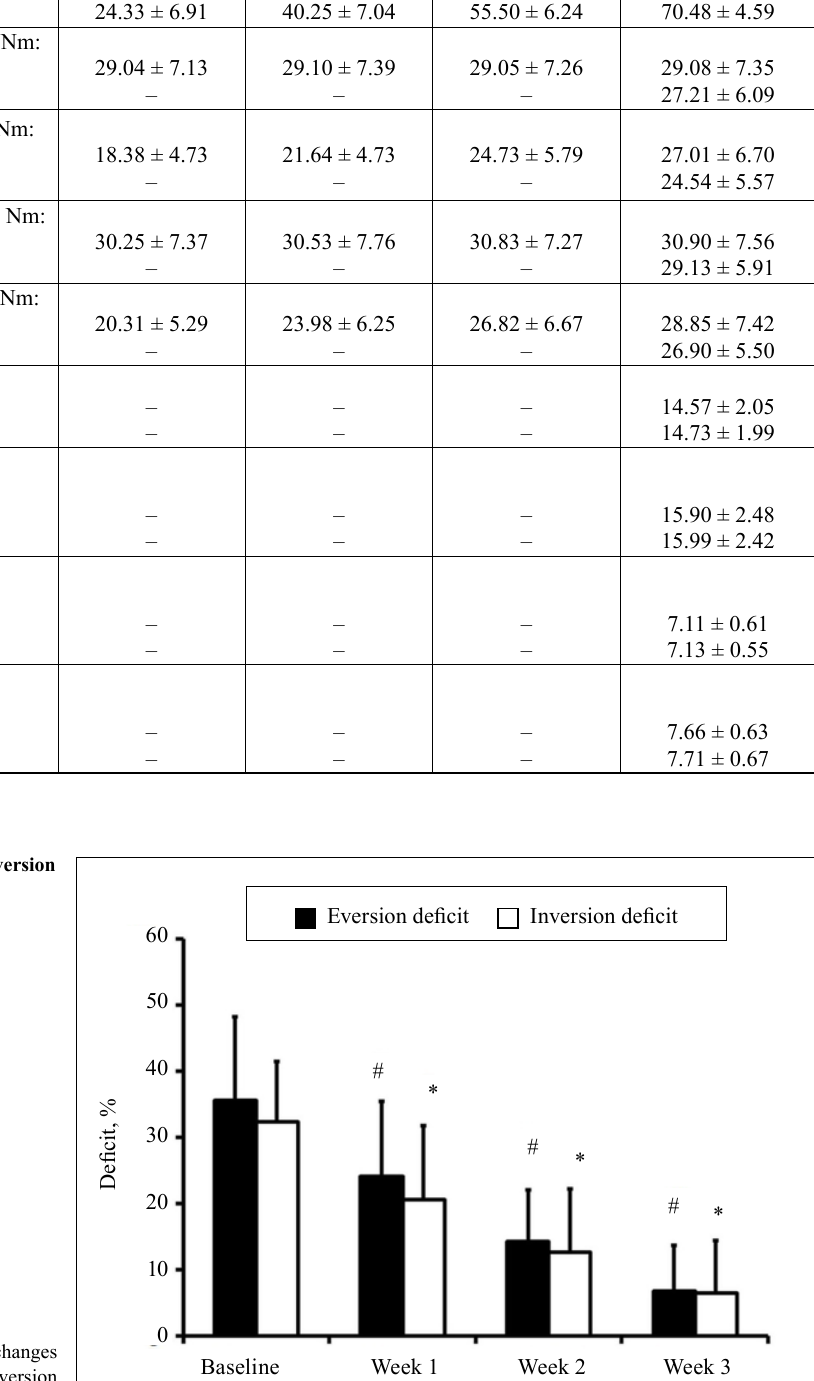
Note. # – statistically reliable eversion changes (p < 0.05); * – statistically reliable inversion changes (p <